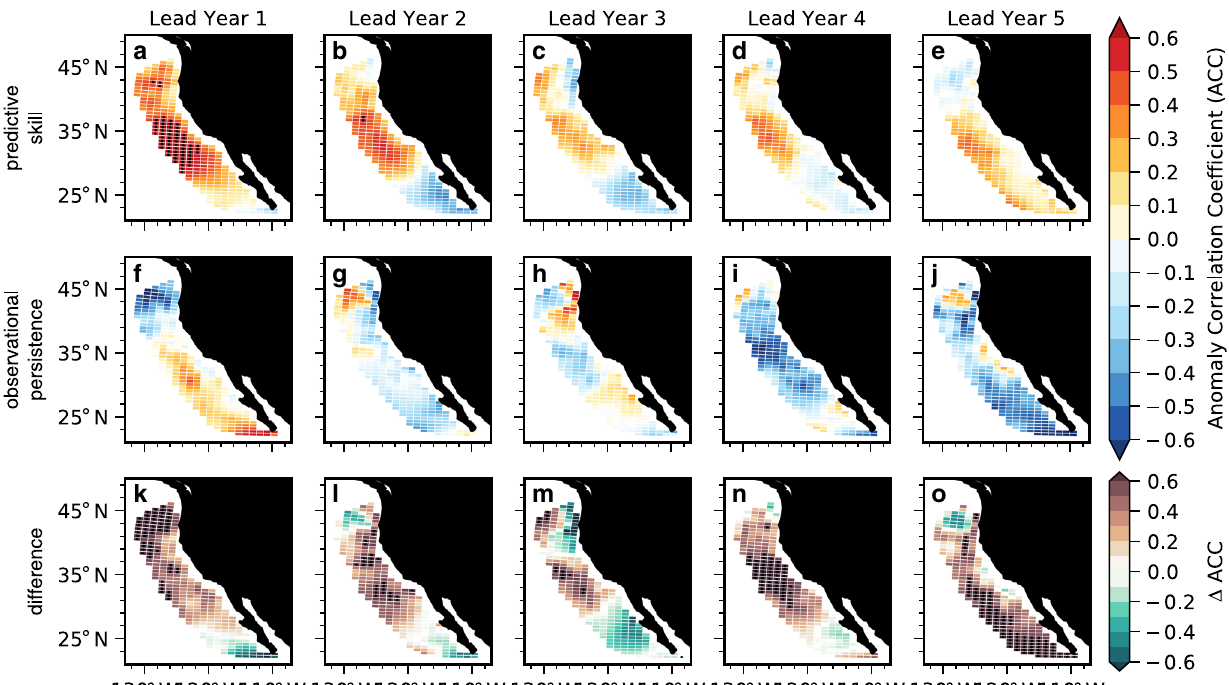
Fig. 5 Predictive skill of surface pH anomalies. a – e Community Earth System Model Decadal Prediction Large Ensemble (CESM-DPLE) initialized forecasts of detrended annual surface pH anomalies for lead years one through fi ve correlated with the observational product over 1990 – 2005. f – j Persistence forecast for the observations for lead years one through fi ve. Stippling in a – j denotes statistically signi fi cant correlations at the 95% level using a t test. An effective sample size is used in the t test to account for autocorrelation in the two time series being correlated. k – o Difference between the CESM-DPLE forecast anomaly correlation coef fi cients (ACCs) and observational persistence. Stippling indicates that the initialized prediction is statistically signi fi cant over the observational persistence forecast at the 95% level using a z test. Only positive ACCs and Δ ACCs are